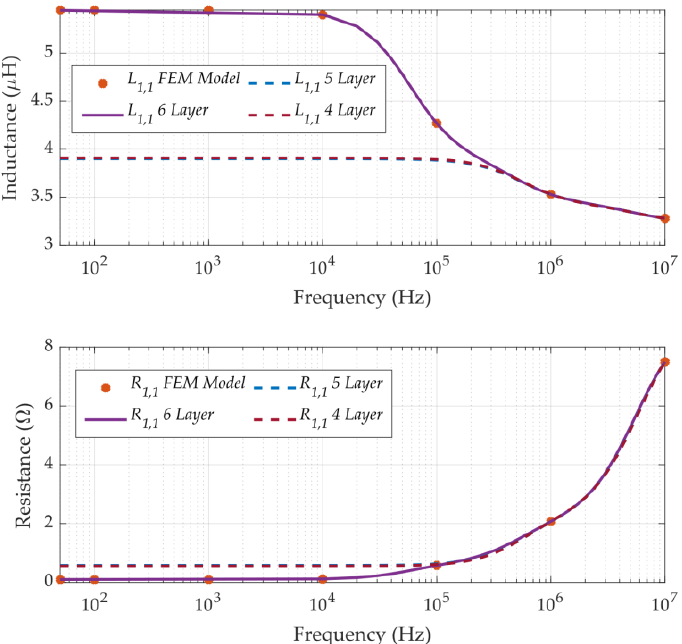
Figure 13. The flowchart to calculate elements in ladder circuits using vector fitting.